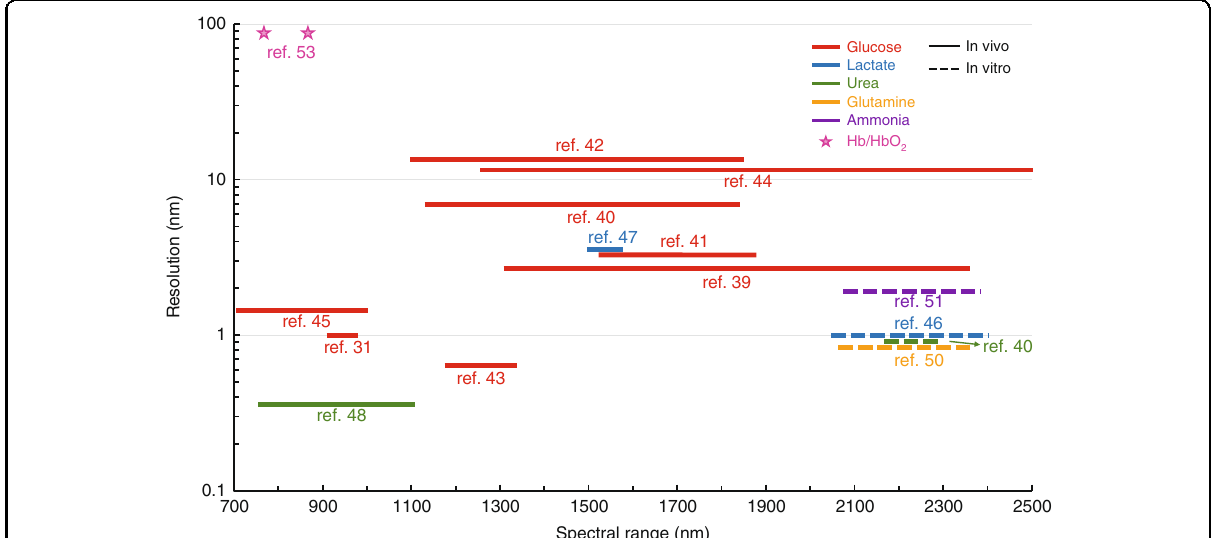
Fig. 4 Summary of the spectrometer speci fi cations for the detections of various biomarkers based on published demonstrations. Solid and dashed lines correspond to in-vivo and in-vitro testing,